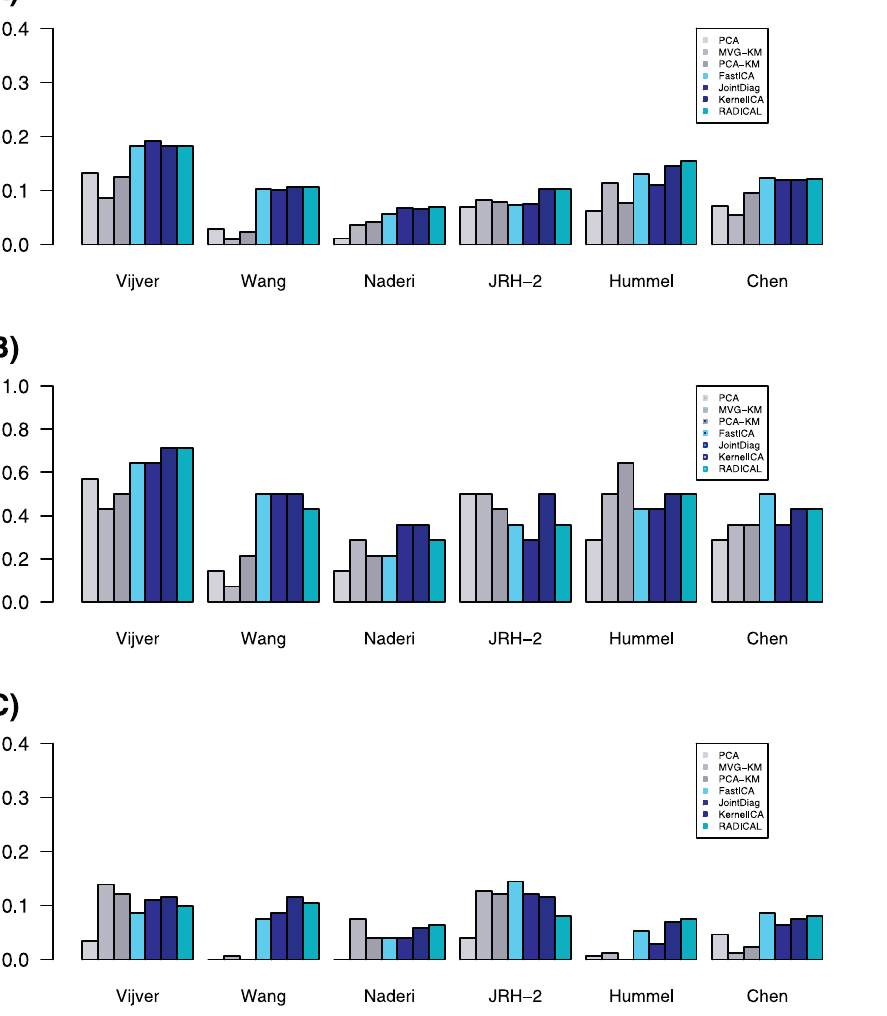
Figure 2. Testing the ICA Paradigm (A) For each cohort and method, we give the pathway enrichment index, PEI, defined by the fraction of biological pathways (536 in total) found enriched in at least one component. (B) For each cohort and method, we give the fraction of cancer-signalling and oncogenic pathways (14 in total) successfully mapped by the inferred components. (C) For each cohort and method, we give the fraction of motif-regulatory gene sets (173 in total) captured by the inferred components.